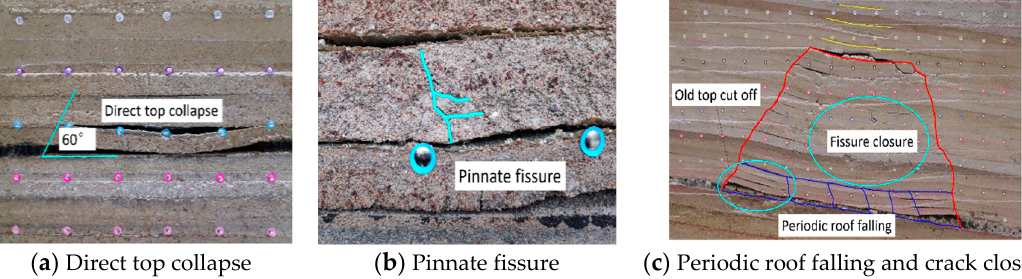
Figure 11. Diagram of the development of water-conducting fracture zone in working face.